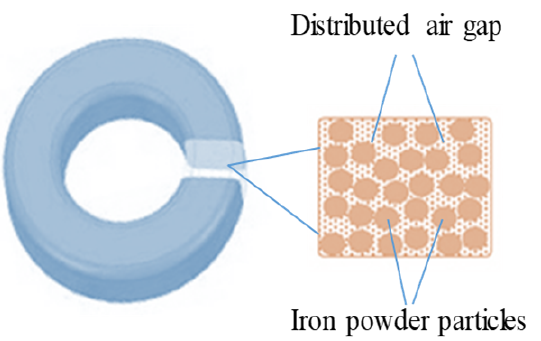
Figure 3. Proposed toroidal core with distributed air gap composed of resin and iron powder parti- cles.